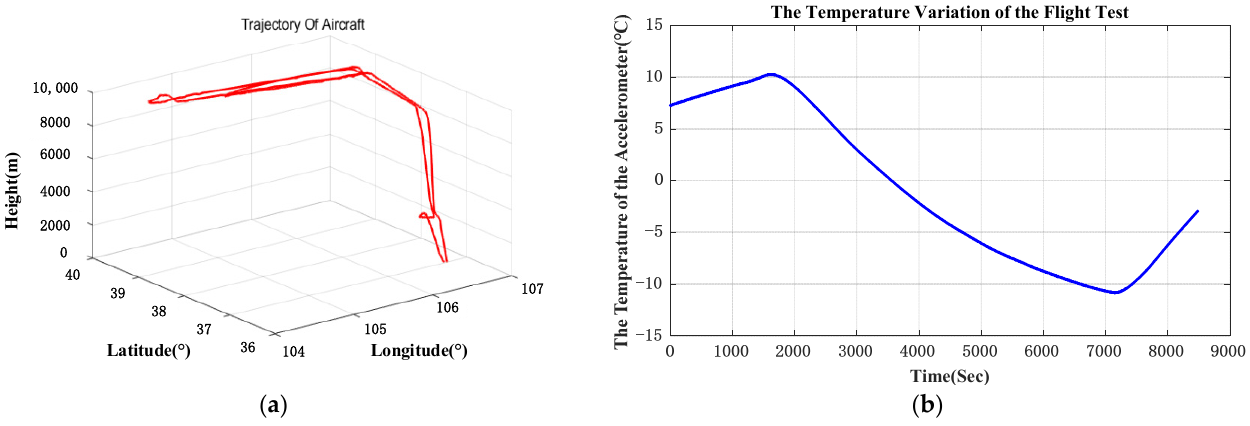
Figure 11. ( a ) is flight path of aircraft; ( b ) is temperature of IMU during the flight. Start-up and Climbing: It took about 30 min to climb to 10,000 m. The temperature of the INS rose at the beginning period because of the heat generated by the circuits of